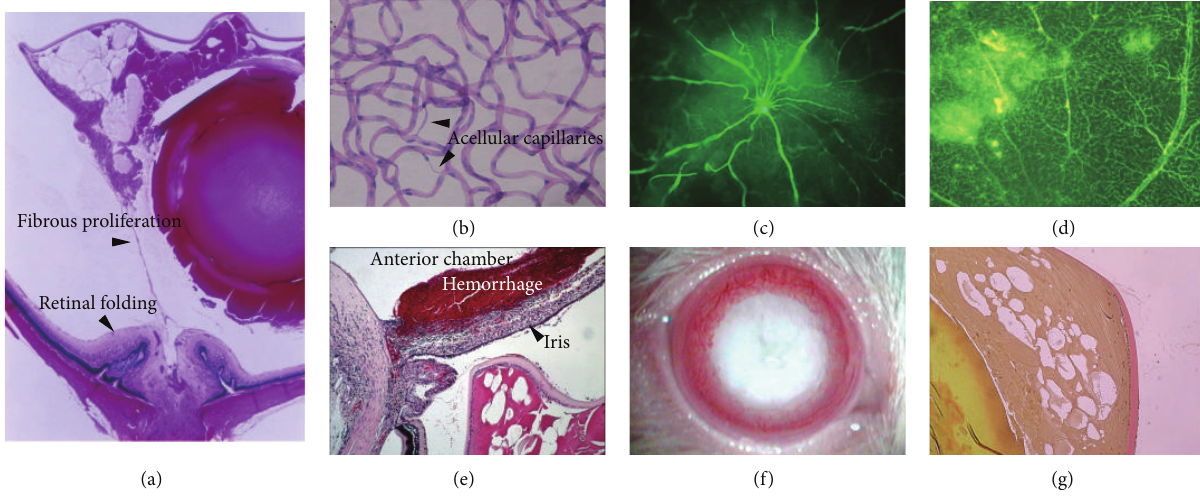
e SSLP markers which are the closest to maximum peaks of QTLs are shown. b